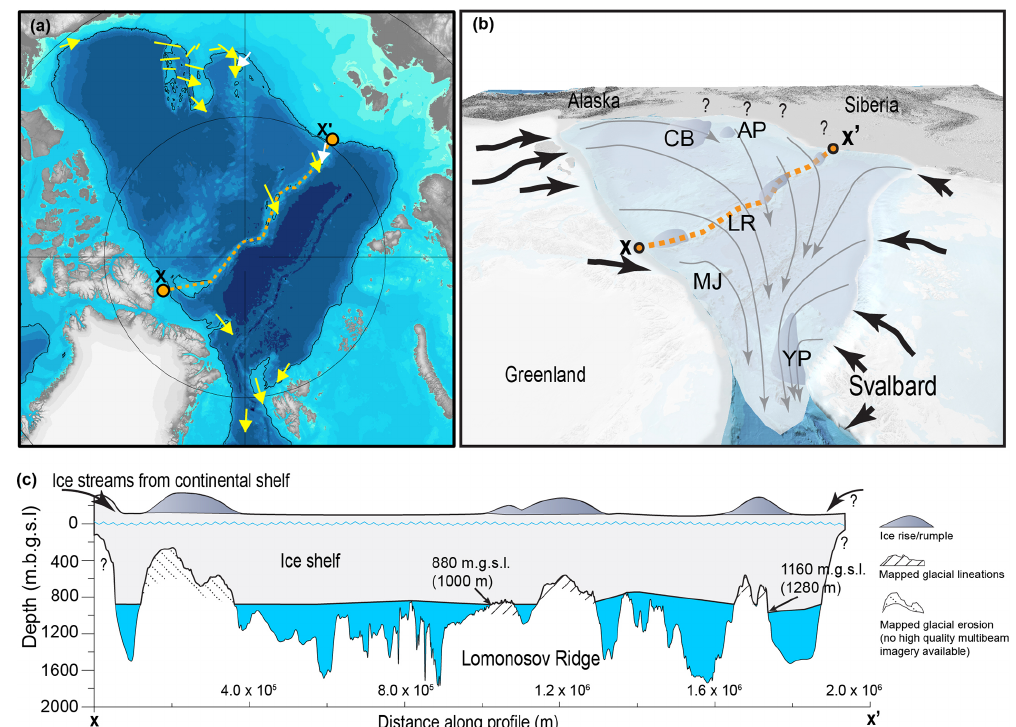
Figure 1. Outline of the glacial Arctic Ocean ice shelf adopted from Jakobsson et al. (2016). (a) Present-day land distribution and water depth (blue colours) and observationally inferred ice-shelf flow directions (arrows, see the text for details). The black line shows 1000m isobath. The Lomonosov Ridge (along the dotted line) separates the Amerasian Basin from the Eurasian Basin, located towards the Fram Strait between Greenland and Svalbard. (b) Qualitative depiction of the ice-shelf extent and flow based on ice-erosion data from the Chukchi Border Land (CB), the Arlis Plateau (AP), the Lomonosov Ridge (LR), the Morris-Jessup Rise (MR), and the Yermak Plateau. Question marks indicate possible east Siberian ice sheets (Niessen et al., 2013; Jakobsson et al., 2014). (c) shows a section along the Lomonosov Ridge, illustrating how the shelf grounds on ridge and the sub-ice channels that allow water circulation into the Amerasian ice